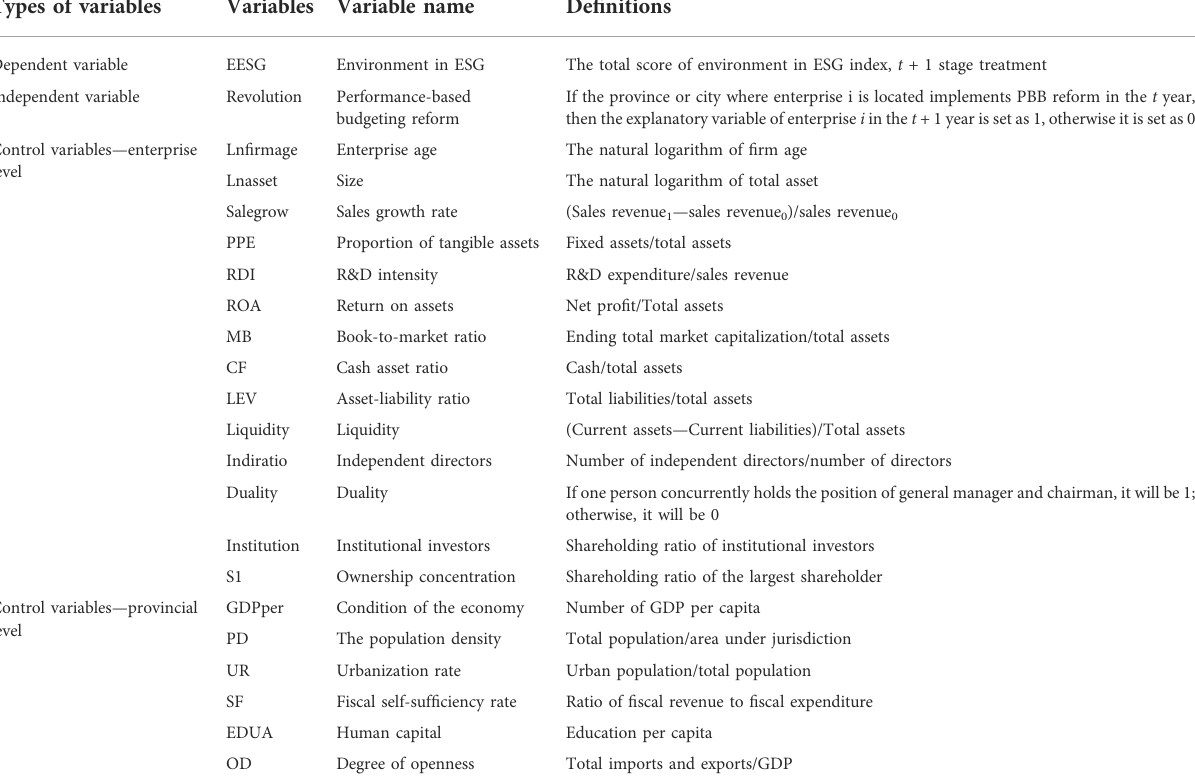
TABLE 2 The de fi nitions of the main